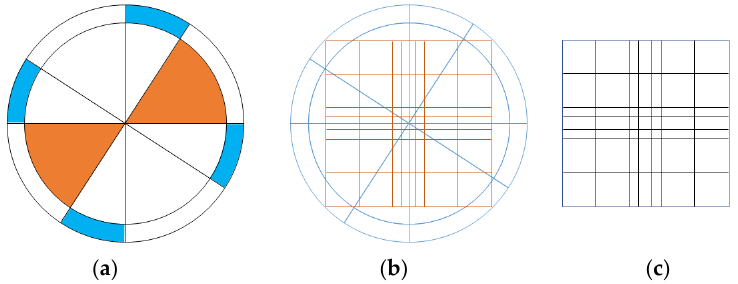
Figure 5. The axial cross-sections of the VESSELs and the intersection of the cells. ( a ) The CY-V; ( b ) intersections of the cells; ( c ) the CA-V.